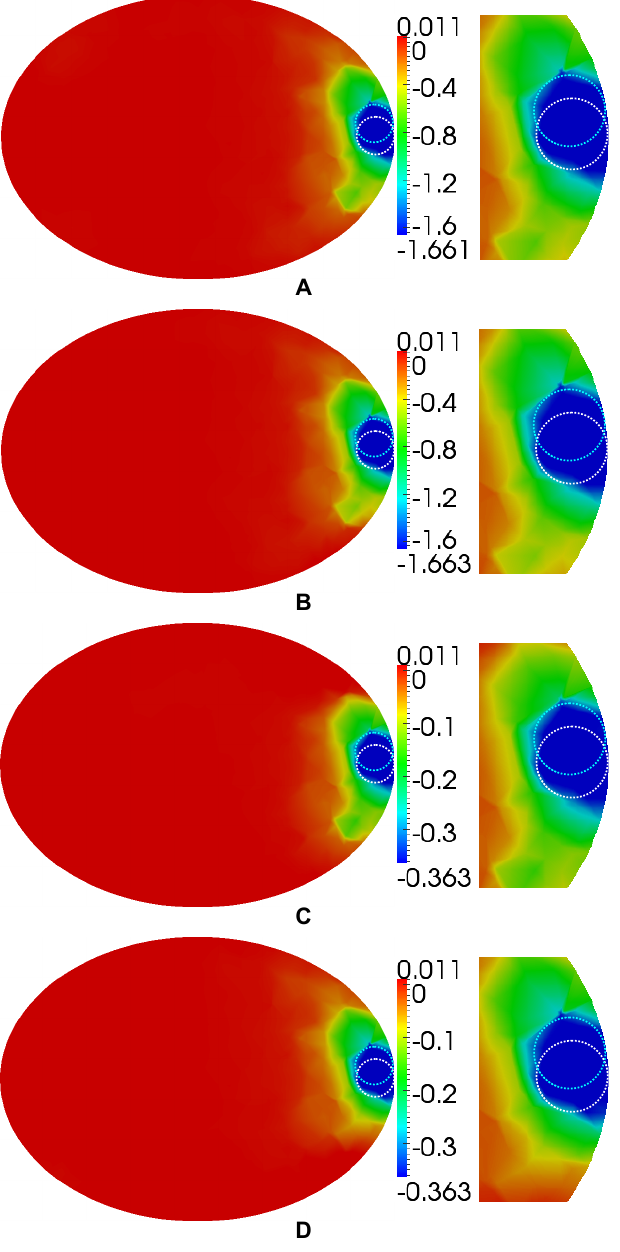
Fig. 6: Reconstructed images Im(Δ σ err ) of the rotated target medium in the error detection measurements . A: with an active marker at 500 kHz , B: with a passive marker at 500 kHz , C: with an active marker at 200 kHz , D: with a passive marker at 200 kHz . The dotted white and cyan circles mark the initial and final positions of the sphere before and after rotation, respectively.